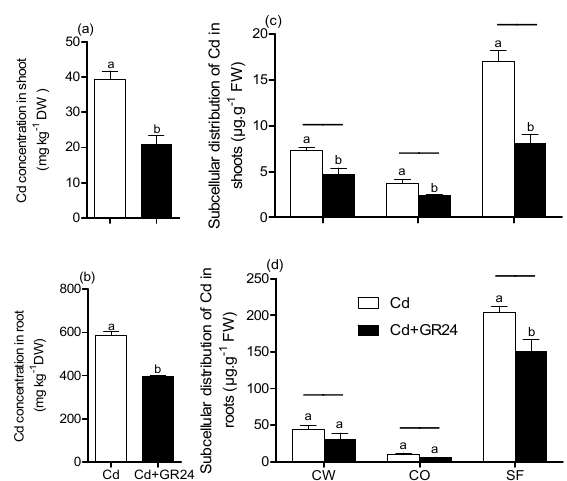
Figure 2 . The effects of the GR24 on Cd concentration and subcellular distribution in plant tissues. Values are means ± SD ( n = 3). CW: cell wall; CO: cell organelle; SF: solutable fraction. The dates of CK and GR24 are not shown in this Figure. Different letters above the bars were significantly different ( a , b ), significant differences under the same horizontal line ( c , d ) at p < 0.05. DW: dry weight; FW: fresh weight.